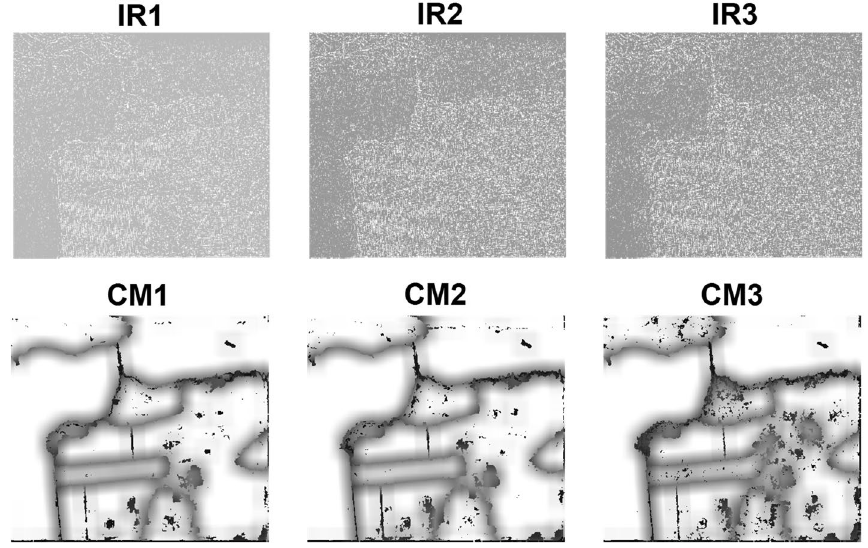
Figure 4. Important regions (IRs) and confidence maps (CMs) for three views of SanFrancisco dataset.